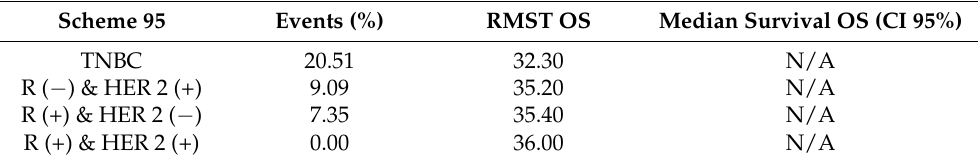
Figure 9. OS IHC distribution. IHC: immunohistochemistry, OS: overall survival, Type I: triple negative breast cancer, type II: hormonal receptors negative, Her 2/neu positive, type III: hormonal receptors positive, Her 2/neu negative, type IV: hormonal receptors positive, Her 2/neu positive. Table 5. OS IHC survival data.